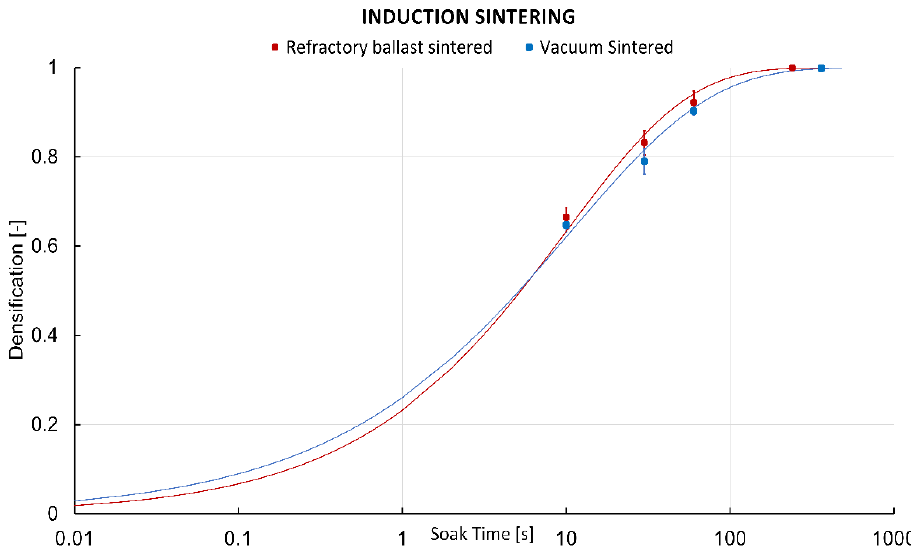
Figure 8. Johnson – Mehl – Avrami – Kolmogorov (JMAK) model curves of the 316L FFF parts sin- Figure 8. Johnson–Mehl–Avrami–Kolmogorov (JMAK) model curves of the 316L FFF parts sintered tered within the refractory ballast (red), and in a vacuum (blue). within the refractory ballast (red), and in a vacuum